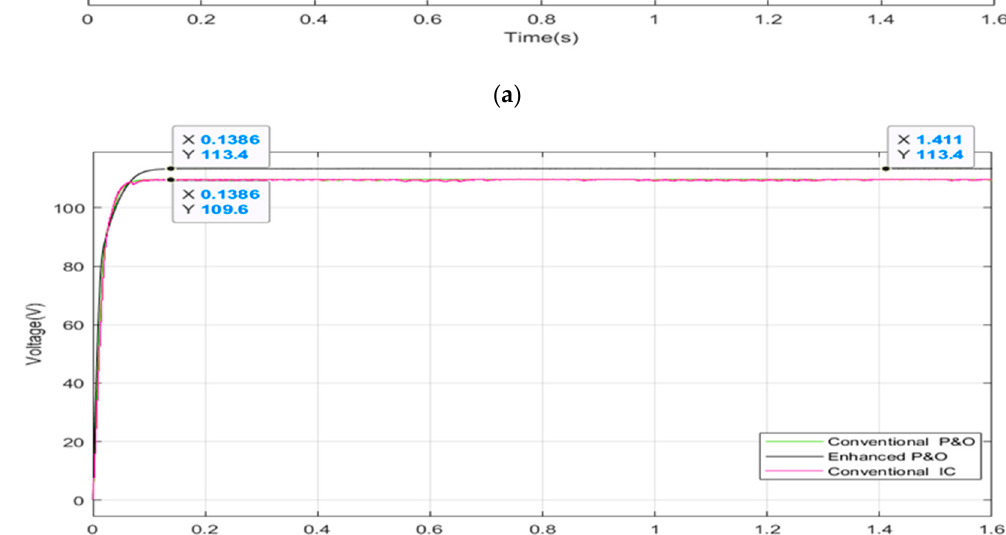
( c ) Figure 12. The simulation results of the proposed technique and the conventional P&O and IC techniques for Case Three: ( a ) Tracked output power; ( b ) Output voltage of the boost converter; ( c ) Duty cycle behaviors. 5.4. Case Four: Strong Partial Shading Pattern In this case, two connected panels receive uniform radiation conditions (1000 W/m 2 radiation), while two receive 600 W/m 2 and four receive 400 W/m 2 . The arrangement is illustrated in Table 2. Four maxima occur in the P–V characteristics. The location of the GMPP is shown in the characteristics in Figure 13. The simulation results for Case Four with a performance comparison between the proposed technique and the conventional P&O and IC techniques are illustrated in Figure 14.